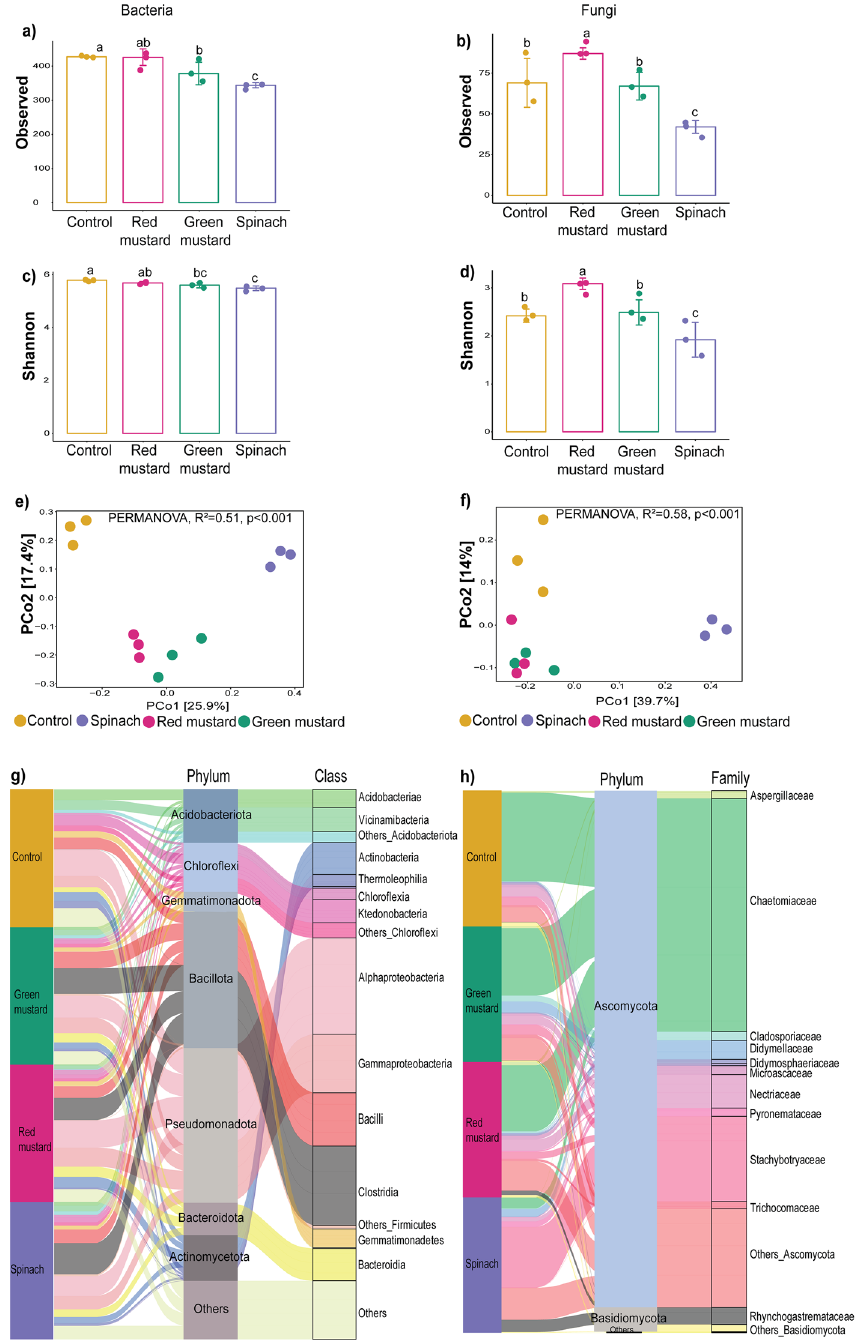
Figure 1. Changes in soil microbial diversity and community structure after green manuring. Alpha diversity of bacteria ( a , c ) and fungi ( b , d ) in green manure treatments measured by observed and Shannon indices. Mean values (n = 3) followed by different letter (s) in each parameter represent significant differences at p ≤ 0.05, DMRT test. Principal coordinate analysis (PCo1 and PCo2) of bacteria ( e ) and fungi ( f ) communities based on Bray–Curtis distance. Taxonomic composition (> 0.1%) of bacterial ( g ) and fungal communities ( h